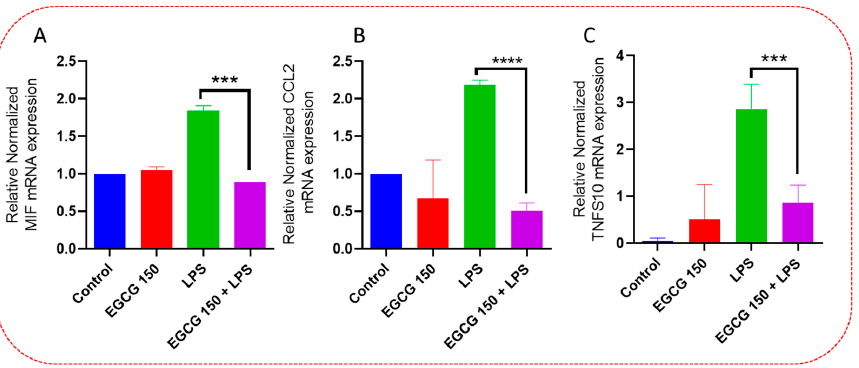
Figure 6. EGCG downregulates MIF, CCL2, and TNFS10. PCR array evaluation of BV-2 cells demonstrated that EGCG 150 µM + LPS reduces the mRNA expression of proin fl ammatory mediators: MIF ( A ), CCL2 ( B ), and TNFS10 ( C ). LPS 1 µg/mL considerably elevated mRNA expression of MIF, CCL2, and TNFS10 when contrasted to 150 µM and 1 µg/mL LPS. The controls (untreated cells and EGCG 150 µM alone) varied in expression due to the e ff ects of EGCG on these speci fi c genes. Values represent the mean ± SD, *** p ≤ 0.001, and **** p ≤ 0.0001 vs. LPS.